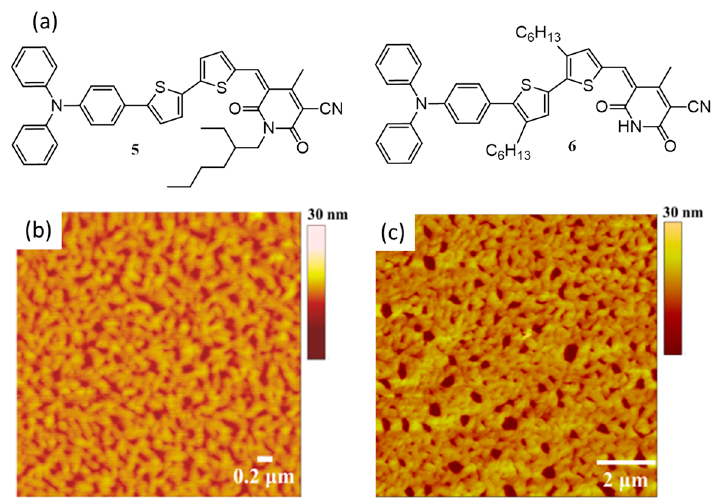
Figure 4. ( a ) Chemical structures of 5 and 6 synthesized by Kumar et al. [51]. AFM height image of observed nanostructures of films drop-cast from ( b ) 1 mg/mL and ( c ) 10 mg/mL chloroform solution of 6 . Adapted from Ref. [51] which is an Open Access article under the terms of the Creative Commons Attribution License (http://creativecommons.org/licenses/by/2.0).